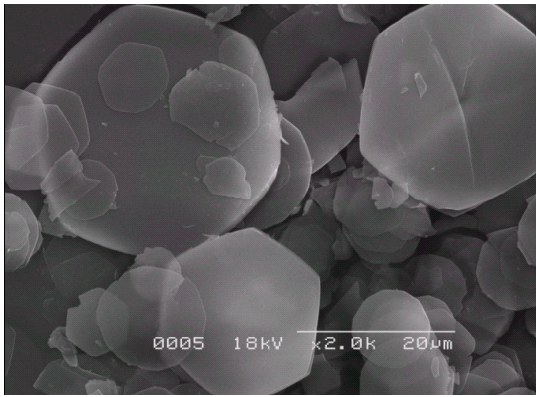
Figure 8. SEM image of a large platy particle of CoAl-LDH. Reproduced with permission from reference [81].